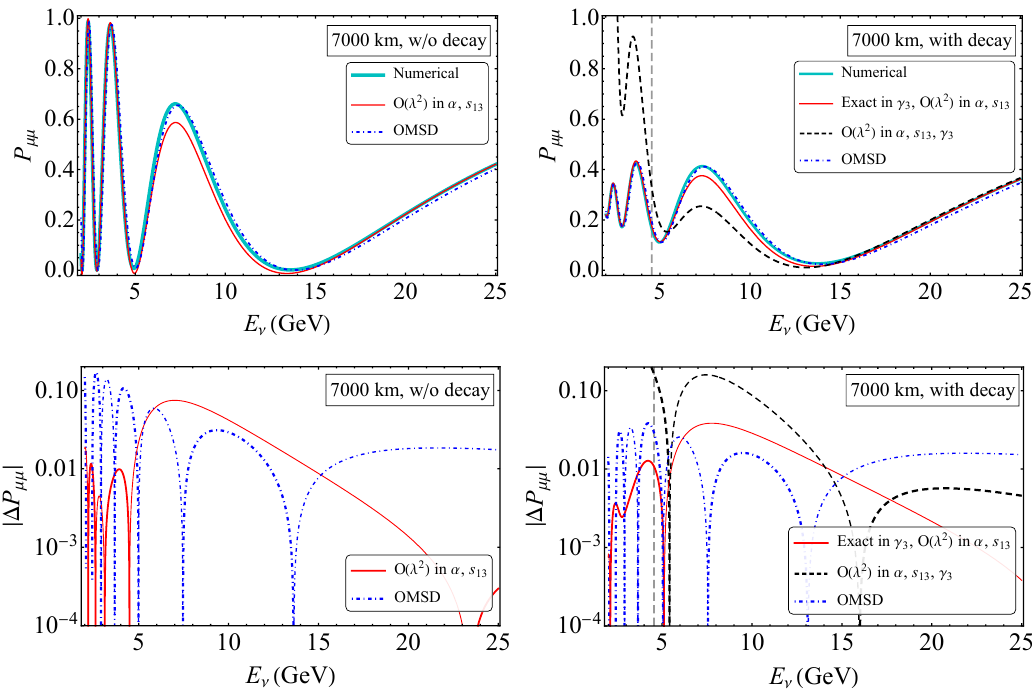
Figure 3 . The top panels show probabilities P µµ in the scenarios without (left) and with (right) decay, for L = 7000 km and γ = 0 . 1 . The bottom panels show the absolute error | ∆ P 3 analytic expressions shown. The thick (thin) curves indicate positive (negative) signs of ∆ P dashed vertical line at E 4 . 5 GeV corresponds to λ ∆ = 1 , to the left of which the expansion in ν ' γ 3 is not expected to be